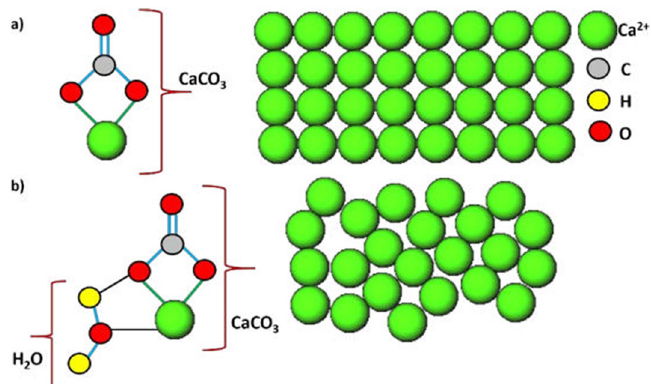
Figure 7. Arrangement of atoms in the amorphous phase vs crystalline phase of calcium carbonate (CaCO 3 ); (a) crystalline calcium carbonate (calcite), (b) Amorphous monohydrated ACC; spheres colored in green represent calcium ions (Ca 2+ ), grey represent carbon atoms (C), yellow represents hydrogen atoms (H) and red represents oxygen atoms (O)